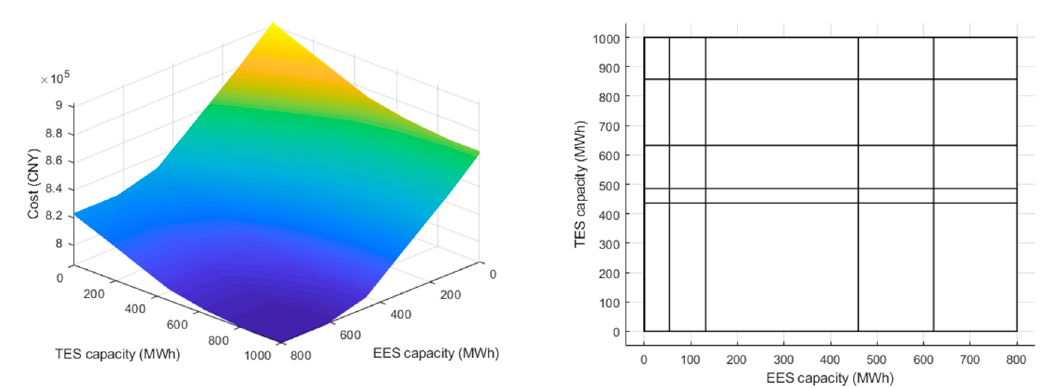
Figure 2. OVFs and critical regions (CRs) with different initial samples.